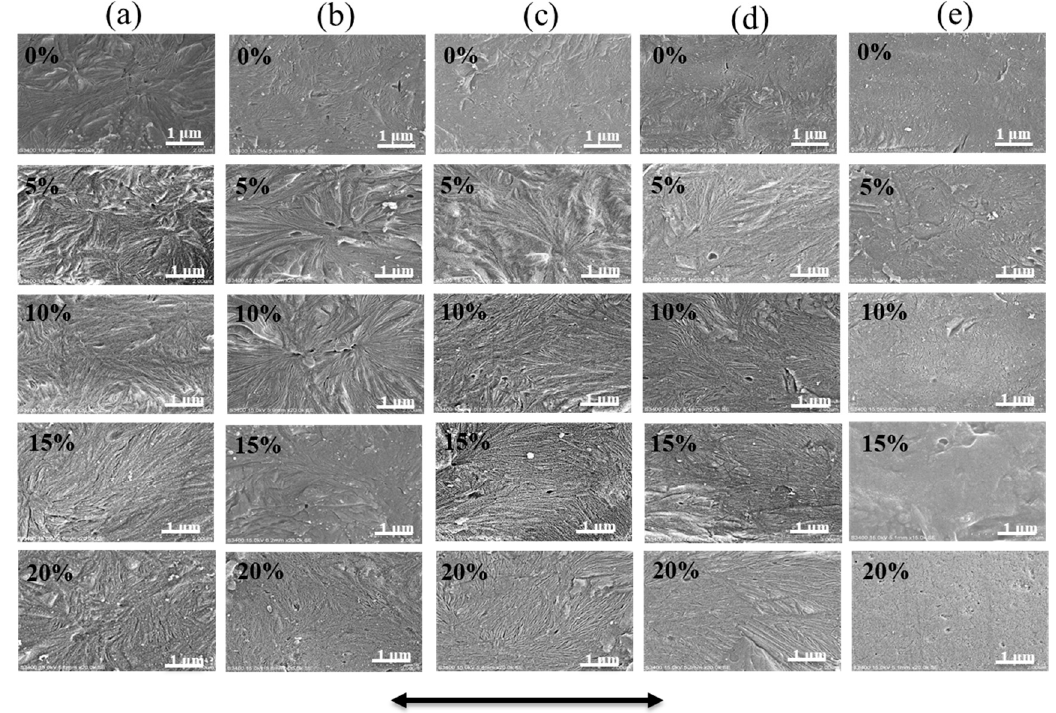
Figure 8. Scanning electron microscopy micrographs of the iPP sheet after stretching at different temperatures: ( a ) 110 °C, ( b ) 120 °C, ( c ) 130 °C, ( d ) 140 °C, and ( e ) 150 °C. The arrow indicates the stretching direction.